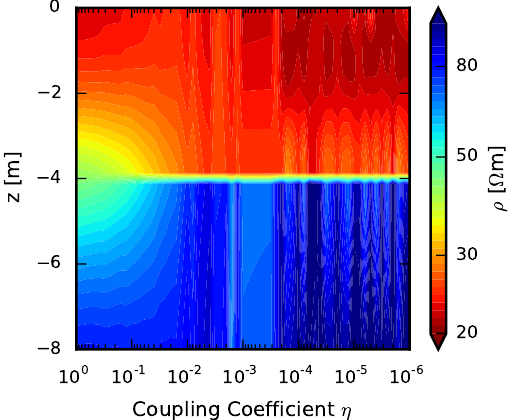
Figure 2. Resistivity profile of 61 inversions with a logarithmic variation of η between one and 10 − 6 . Structural constraints in the inversion that were shifted relative to the layer bound- ary in the synthetic model are used to study the influence of a faulty placed constraint. Resistivity along a vertical line over 8 m in the center of the grid for η = 10 − 4 is shown in Figure 3a). For comparison, the synthetic model and the smooth inversion result are shown as well. Generally, the discrepancy between the inversion result and the model increases with increasing distance between structural constraint and layer boundary, which is driven by a compensation effect. As the upper layer has a lower resistivity compared to the layer beneath, a structural constraint shifted upwards towards the surface with respect to the layer boundary in the model causes lower resistivities in the inversion result than in the model input in both layers. Vice versa, a downward-shifted constraint causes higher resistivities. This compensation effect becomes vital for growing discrepancies between the constraint and the layer